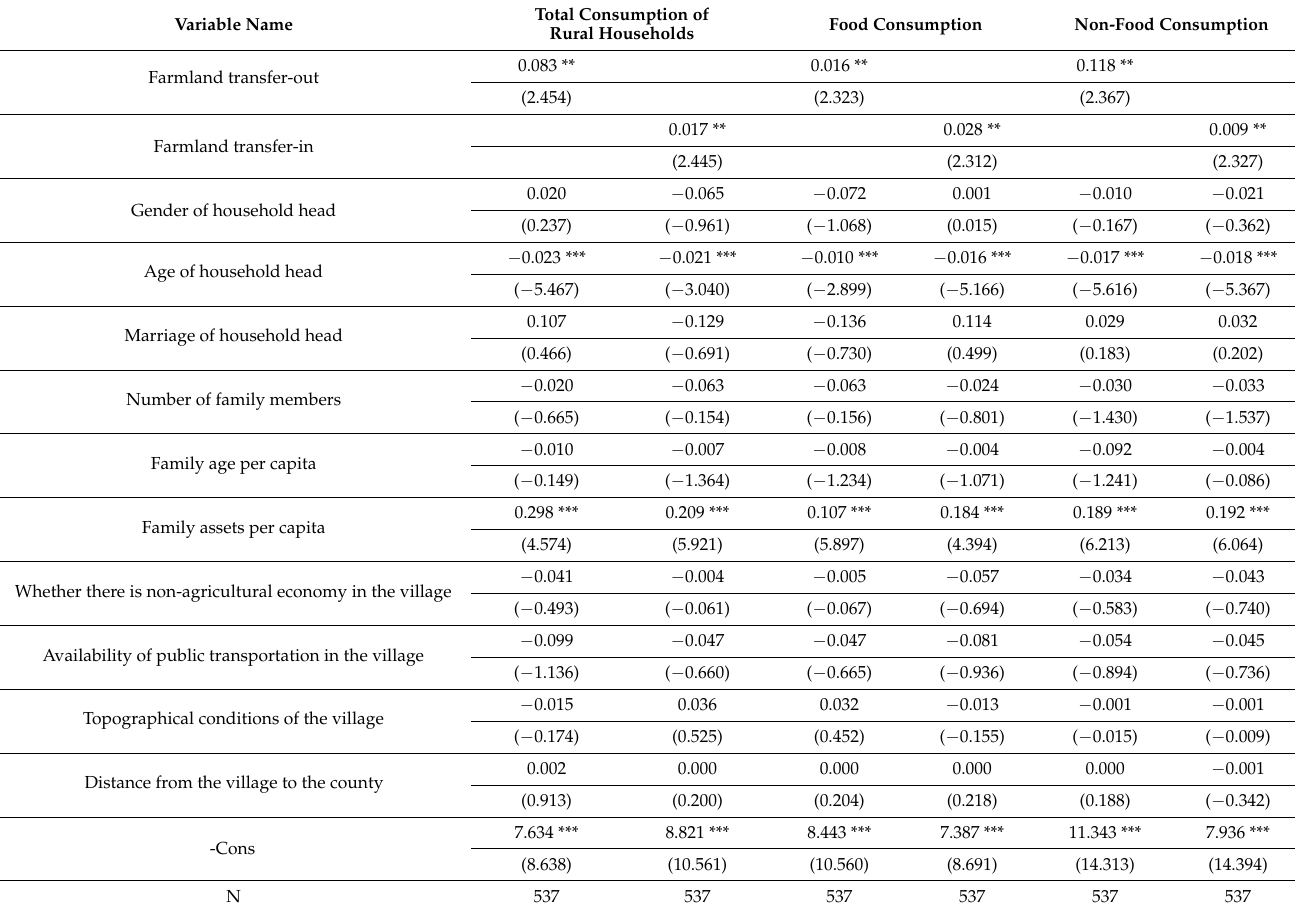
Table 3. Impact of farmland transfer on rural household consumption: Results of benchmark